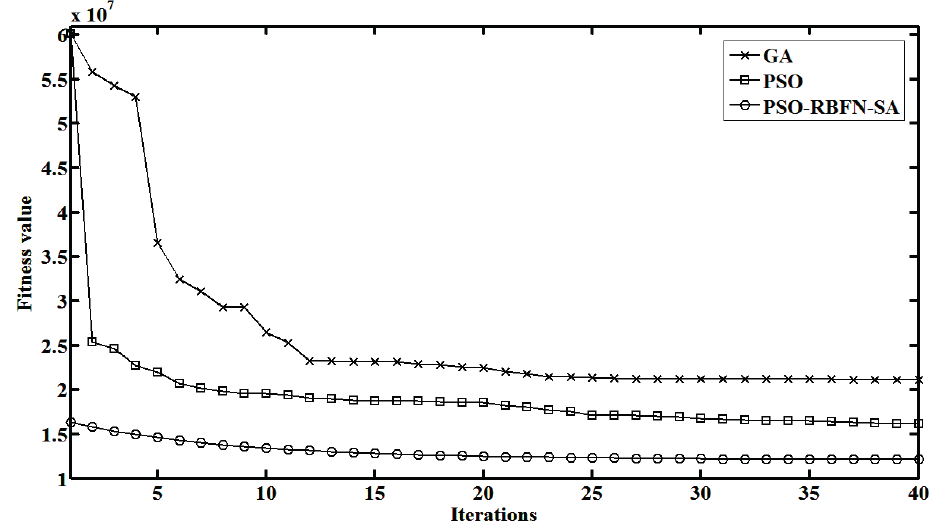
Figure 7. Convergence curves of GA, PSO and PSO-RBFN-SA during online phase.